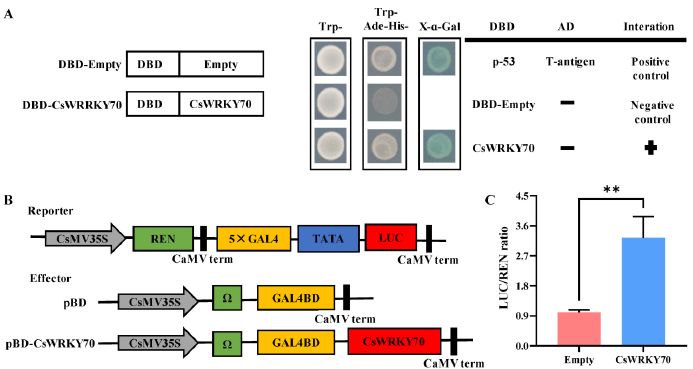
Figure 4. Transcriptional activity characteristics of CsWRKY70 protein. ( A ) Transcriptional activity of CsWRKY70 in yeasts. Co-transformed yeasts were grown on selective media (SD medium with- out tryptophan, histidine, and adenine, SD/−Trp/−His/−Ade). The X- α -galactosidase test was per- formed to evaluate the transcription activation ability of CsWRKY70. ( B ) Transcriptional activity of CsWRKY70 in tobacco system ( Nicotiana benthamiana ). ( C ) The LUC/REN fluorescence intensity ra- tio was determined to evaluate the transcription activation ability of CsWRKY70. SD, synthetic de- fined medium; -Trp/-His/-Ade, medium lacking tryptophan, histidine, and adenine; LUC, Lucifer- ase; REN, Renilla luciferase. ** represents significant differences ( p < 0.01) compared to control. Data were analyzed by Student’s t -tests.